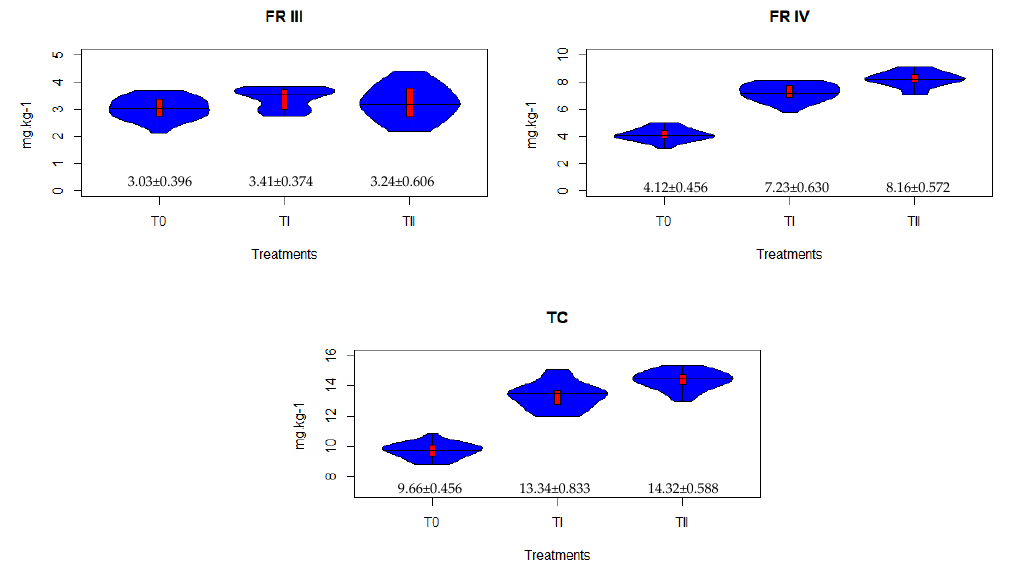
Figure 1. The nickel amounts in soil in dependence on treatments (T0, TI, TII) and used extractant. The values below the graphs are equal mean ± sd.